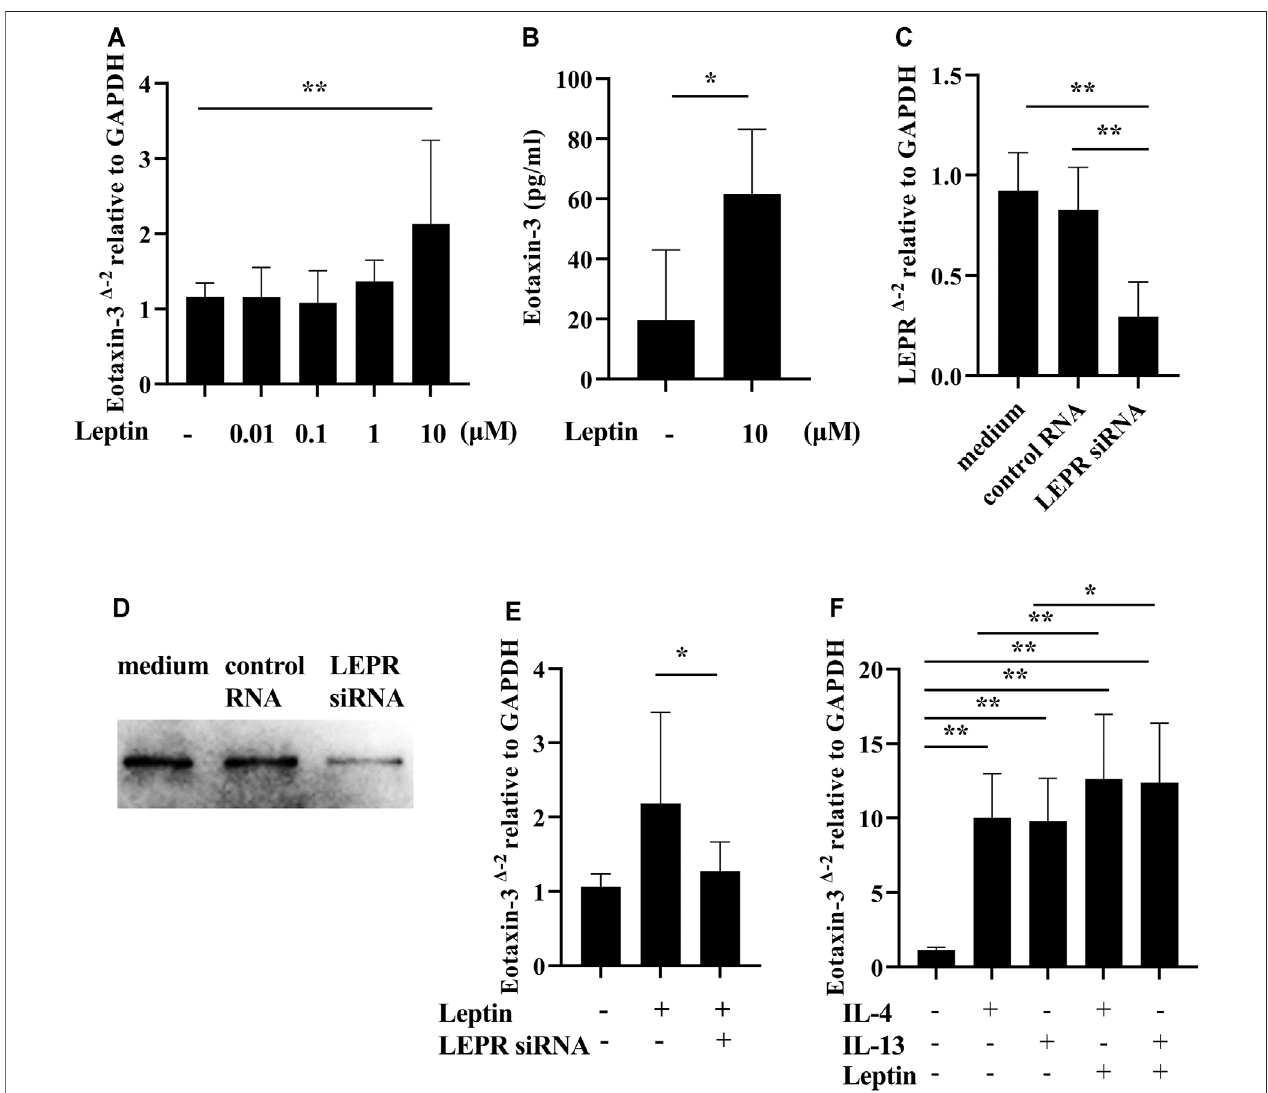
FIGURE 4 | Induction of eotaxin-3 by leptin. (A) Submerged nasal fi broblasts established from nasal polyp cells were stimulated with varying concentrations of leptin( n (cid:1) 8 – 10). (B) Submergednasal fi broblastswereharvestedafterstimulationwith10 μ Mofleptinfor48 h,andwholecelllysateswerecollected.Levelsofeotaxin-3 in the celllysates and medium were measured byELISA ( n (cid:1) 6). (C – E) Submerged fi broblasts weretransfectedwith500 nM ofcontrol RNAand siRNA targeting human leptin receptor. (C) Leptin receptor (LEPR) gene expression analysis. (D) Whole cell lysates were electrophoresed and transferred onto a PVDF membrane. A representativewesternblotwithanti-humanleptinreceptorantibodyisshown. (E) 48 haftertransfection,cellswerestimulatedwith10 μ Mofleptinfor24 h( n (cid:1) 8). (F) IL- 4 (100 ng/ml) and IL-13 (100 ng/ml) with/without leptin (10 μ M) for 24 h. Cell lysates were harvested for RNA toanalyze eotaxin-3 mRNA expression by RT-PCR ( n (cid:1) 8). Data shown are mean ± SEM of four independent experiments. * p < 0.05, ** p < 0.01 compared to non-stimulated cells.